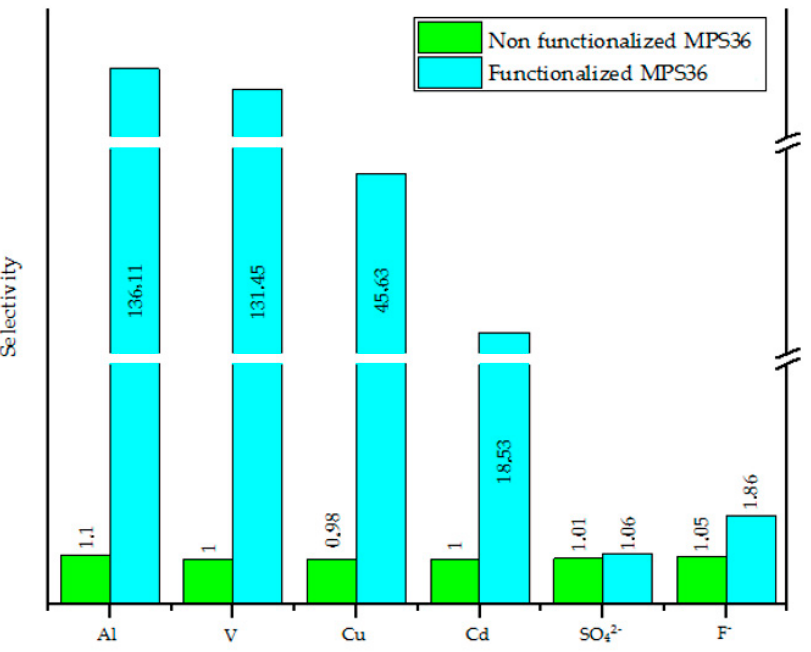
Figure 2. Selectivity of MPS36 and functionalized MPS36.